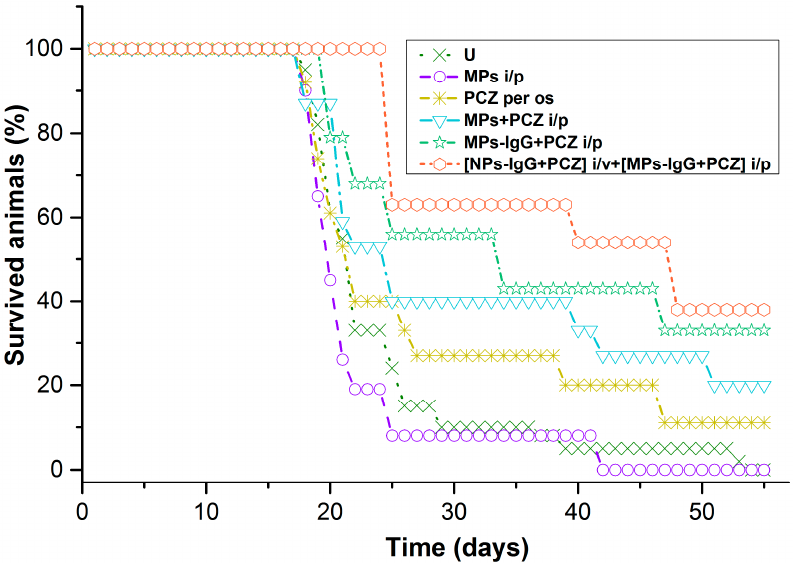
Figure 5. Survival of the multidrug resistance tuberculosis (MDR-TB)-infected mice after various treatments. Time “0” is the starting point of MDR-TB inoculation; the treatment started on the 13th day of infection. Group U: untreated control animals; saline was given orally daily. Group MPs i.p.: mice were treated with drug-free PLA microparticles once intraperitoneally (i.p.) Group PCZ per os: perchlozone was given daily orally as saline solution. Group MPs + PCZ i.p.: mice were treated with perchlozone loaded PLA microparticles, once i/p; Group MPs-IgG + PCZ i/p: the mice were injected once i.p. with perchlozone loaded PLA microparticles with camel IgG. Group [NPs-IgG + PCZ] i.v. + [MPs-IgG + PCZ] i.p. : mice were treated with perchlozone loaded and IgG covered PLA nanoparticles, once i.v. and, after one week, an additional i.p. injection of perchlozone-loaded PLA microparticles was delivered. For peculiarities and doses, see Table